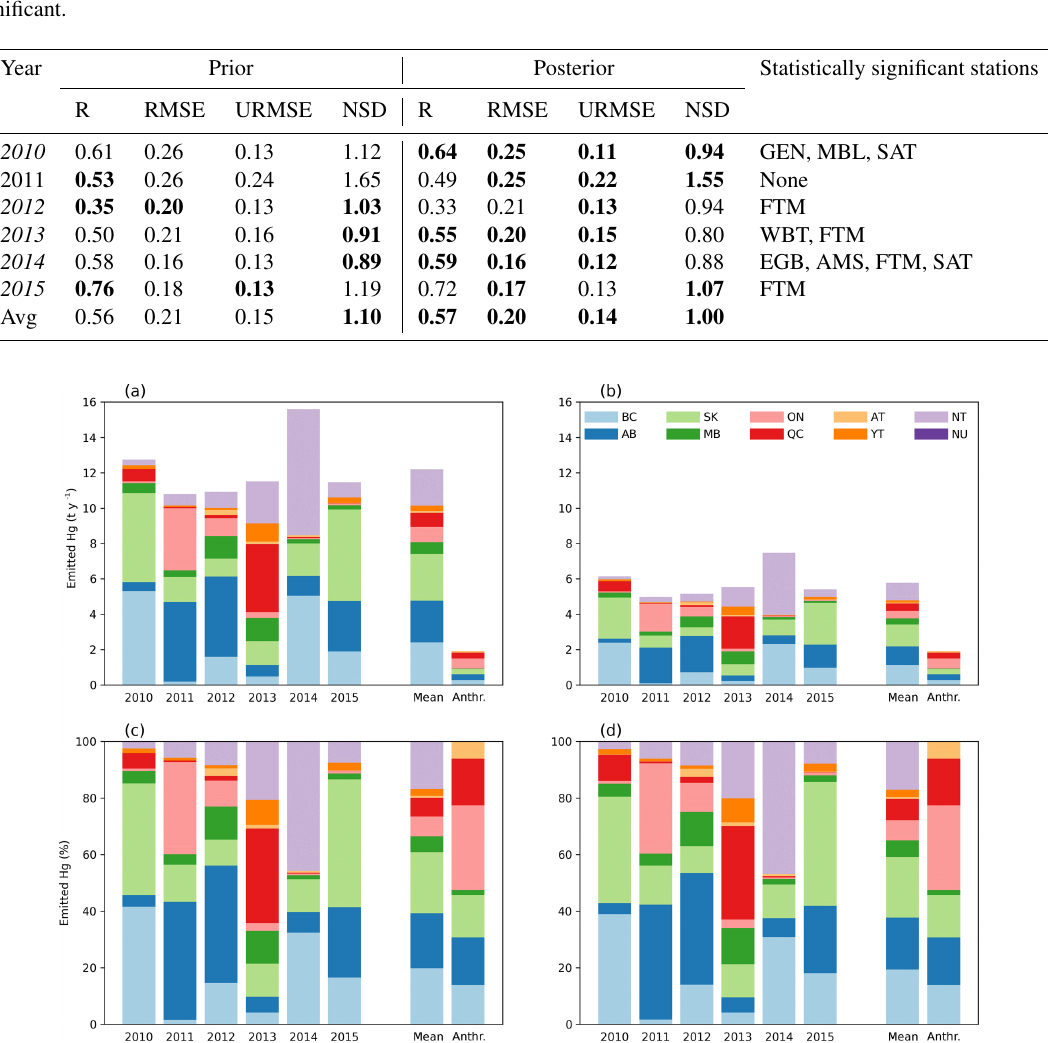
Table 3. Pearson correlation coefficient ( r ), root mean square error (RMSE), unbiased RMSE (URMSE), and normalized standard deviation (NSD) values between model-simulated and observed surface air concentrations of GEM using all observation sites calculated for all indi- vidual years studied and collectively for all years using literature (“Prior”) and optimized (“Posterior”) biomass burning emission factors of Hg. The bolded values indicate better performance of the model. Years in italics indicate years for which the posterior model is significantly different from the prior model, using days for the whole model domain. The final column indicates stations for which the prior and posterior models are significantly different, using only days when fire burning was observed. For both tests of statistical significance, the Student’s t test was used. For the model domain, a p value smaller than 0.01 was deemed significant. For the stations, a p value smaller than 0.10 was deemed significant.